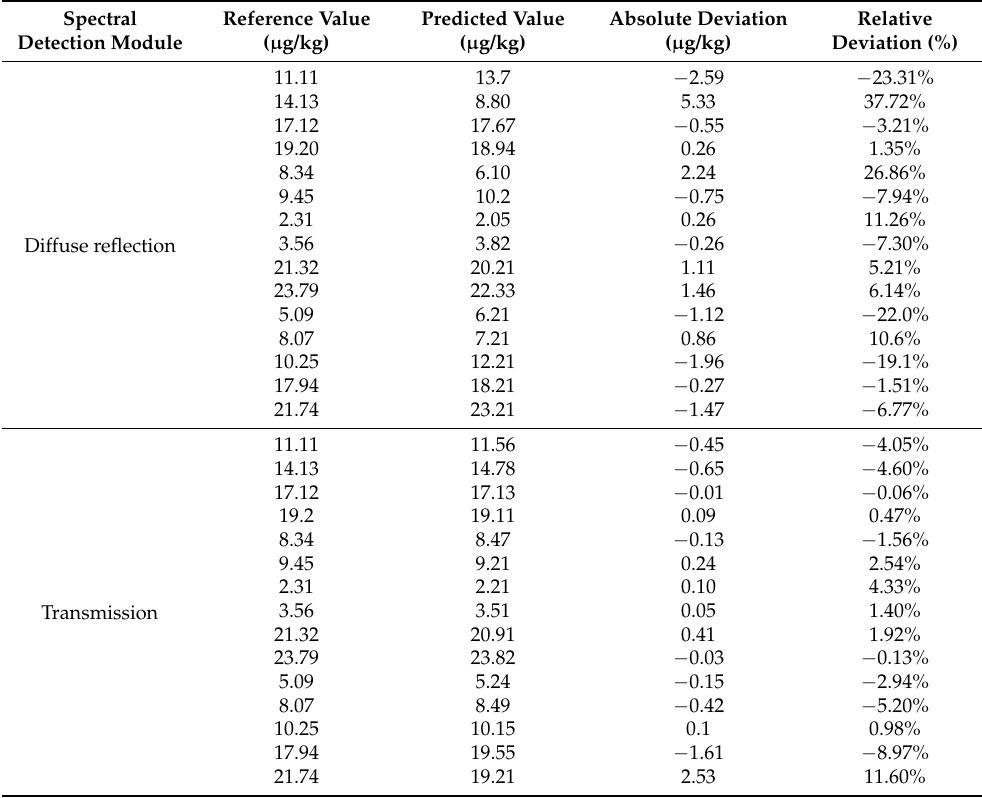
Table 4. Prediction results of the PLS